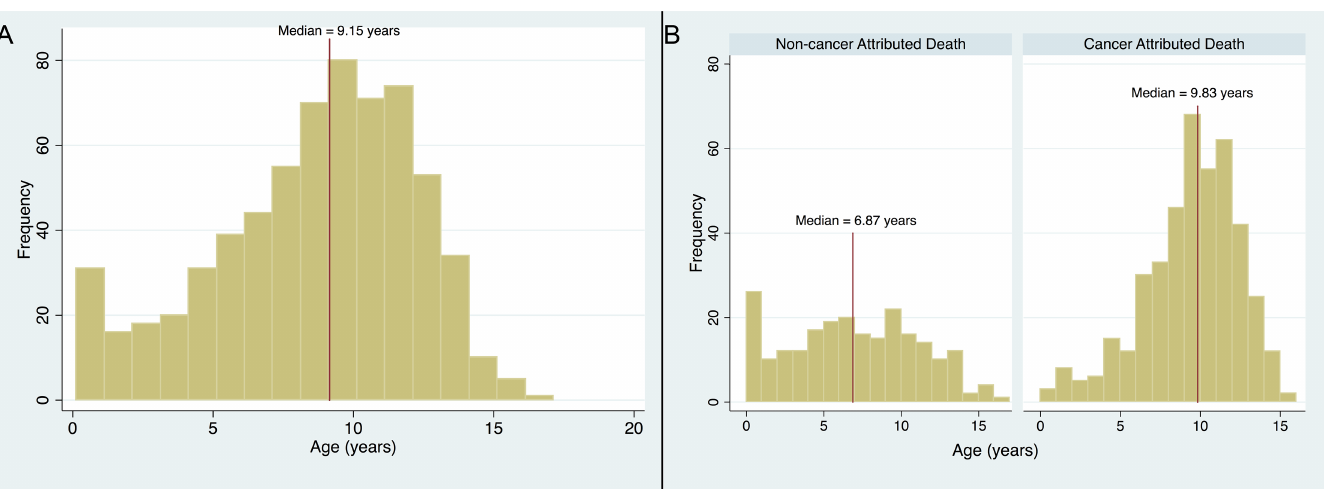
PLOS ONE | https://doi.org/10.1371/journal.pone.0192578 February 6,